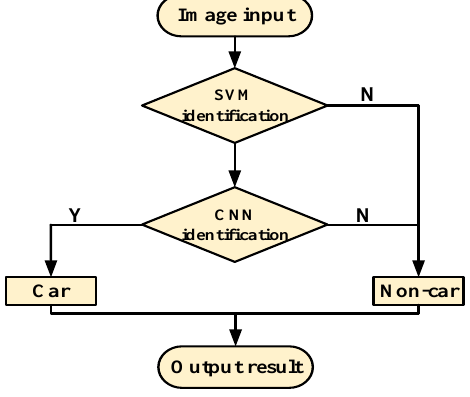
Figure 15. Basic flow of CNN detection.